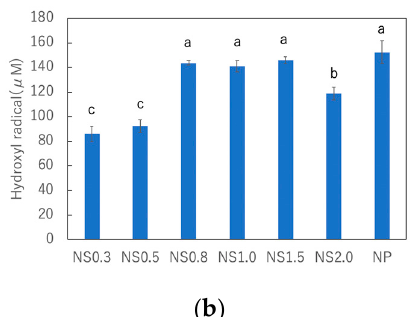
Figure 6. Variation of ln(Ao/A) of MB with reaction time ( a ) under UV irradiation and ( b ) in the dark.